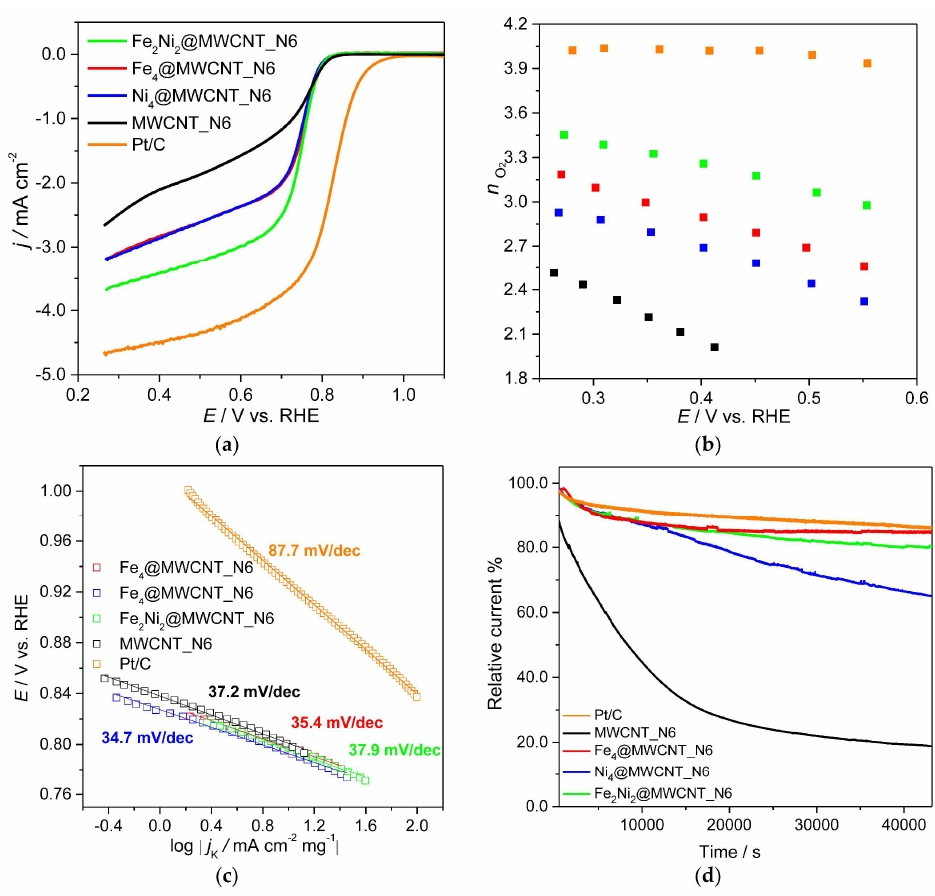
Figure 4. ORR LSV curves obtained in KOH (0.1 M) saturated with O 2 for MWCNT_N6, Fe 4 @MWCNT_N6, Ni 4 @MWCNT_N6, Fe 2 Ni 2 @MWCNT_N6 and Pt/C at 1600 rpm and 0.005 V s − 1 ( a ), n O2 at several potential values ( b ), ORR Tafel plots ( c ) and chronoamperometric responses in KOH (0.1 M) saturated with O 2 at 1600 rpm for 43,200 s ( d